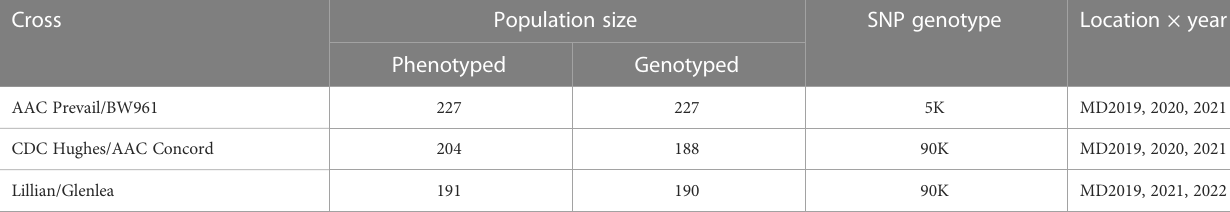
TABLE 1 Description of the doubled haploid wheat populations AAC Prevail/BW961, CDC Hughes/AAC Concord, and Lillian/Glenlea used in the leaf rust resistance study, the number of lines genotyped and phenotyped near Morden (MD), Manitoba, and the year-of- fi eld evaluation.